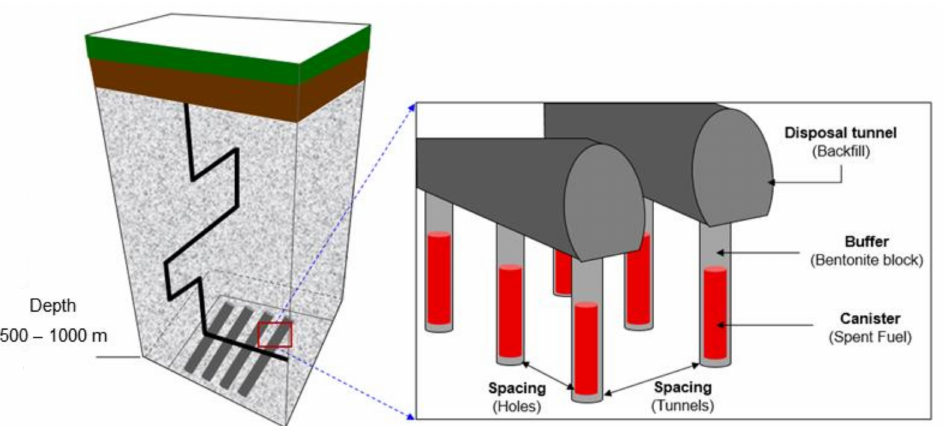
Figure 1. Schematics of deep geological repository and spacing of disposal tunnels and deposition